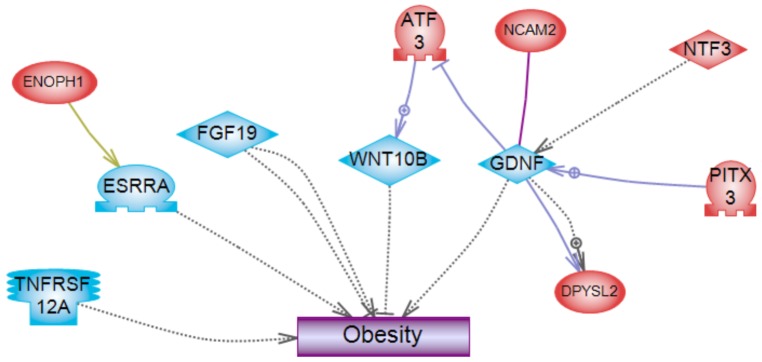
Genes with known links with obesity that correlate with F3 generation plastic lineage sperm DMR associated genes.The correlated DMR associated genes with associations with obesity are presented. The DMR associated genes with indirect connections to the direct connection genes are also presented.